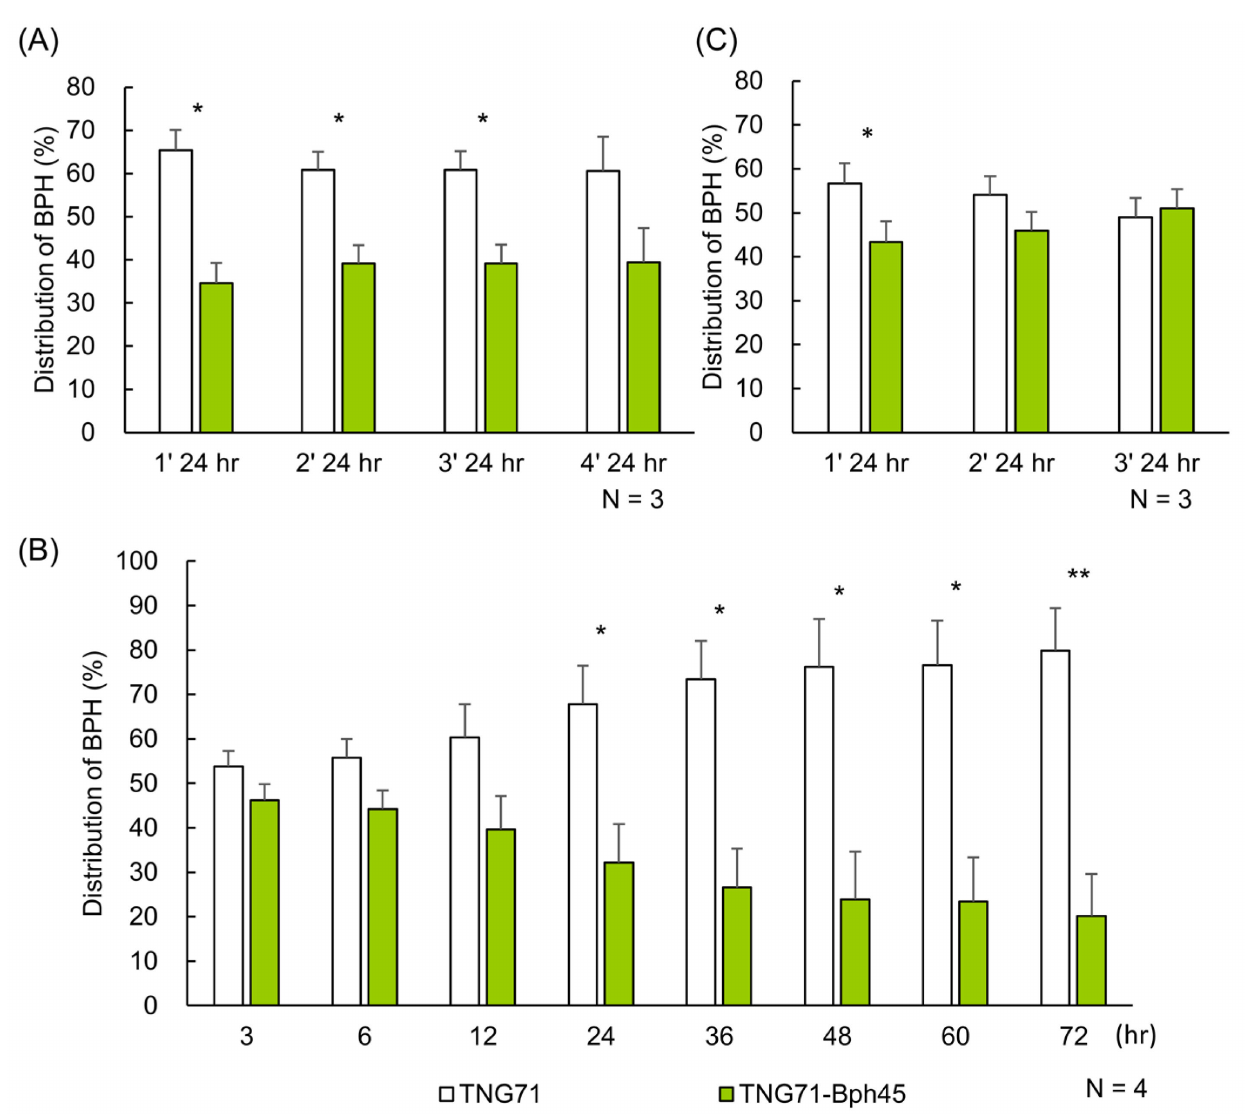
Figure 1. Settling preference of BPH in the host-choice test. Within a BugDorm, pots, each harboring 10 TNG71 or 10 TNG71- Bph45 seedlings, were arranged as described in Materials and Methods. BPHs were released for 24 h and then collected to determine their distributions ( A ) Short-distance test (1–5 cm between BPH and rice). The same population of BPH was released and re-collected for a total of four rounds. ( B ) Short-distance test without disturbance. The BPHs were not collected, but their distributions between TNG71 and TNG71- Bph45 were determined at the indicated times. ( C ) Long-distance test (20–25 cm between BPH and rice). Similar to ( A ) but the same BPH populations were tested for a total of three rounds. Statistical analysis was performed using Student’s paired t -test (N = 3 or N = 4). * p < 0.05 and ** p <